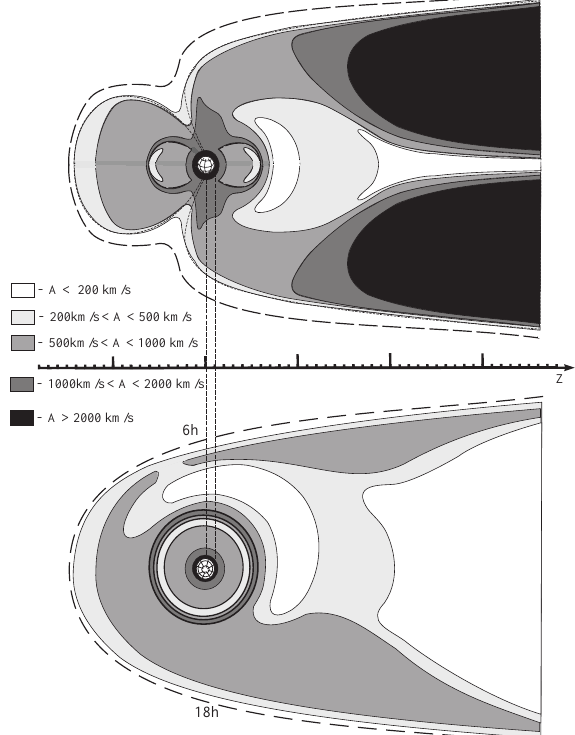
Fig. 1. A sketch of Alfv´en velocity distribution in the meridional (a) and equatorial (b) sections of the magnetosphere. Areas with dif- ferent values of A are shown by varying shades of grey. The NEPS in Fig. 1b has asymmetry due to convective flow of the plasma. An extensive area with a small value of A on the right side of the fig- ure is a section of the plasma sheet in the distant tail. If it deviates from the equatorial plane, this area will be replaced by an area with a greater value of A , corresponding to one of the tail